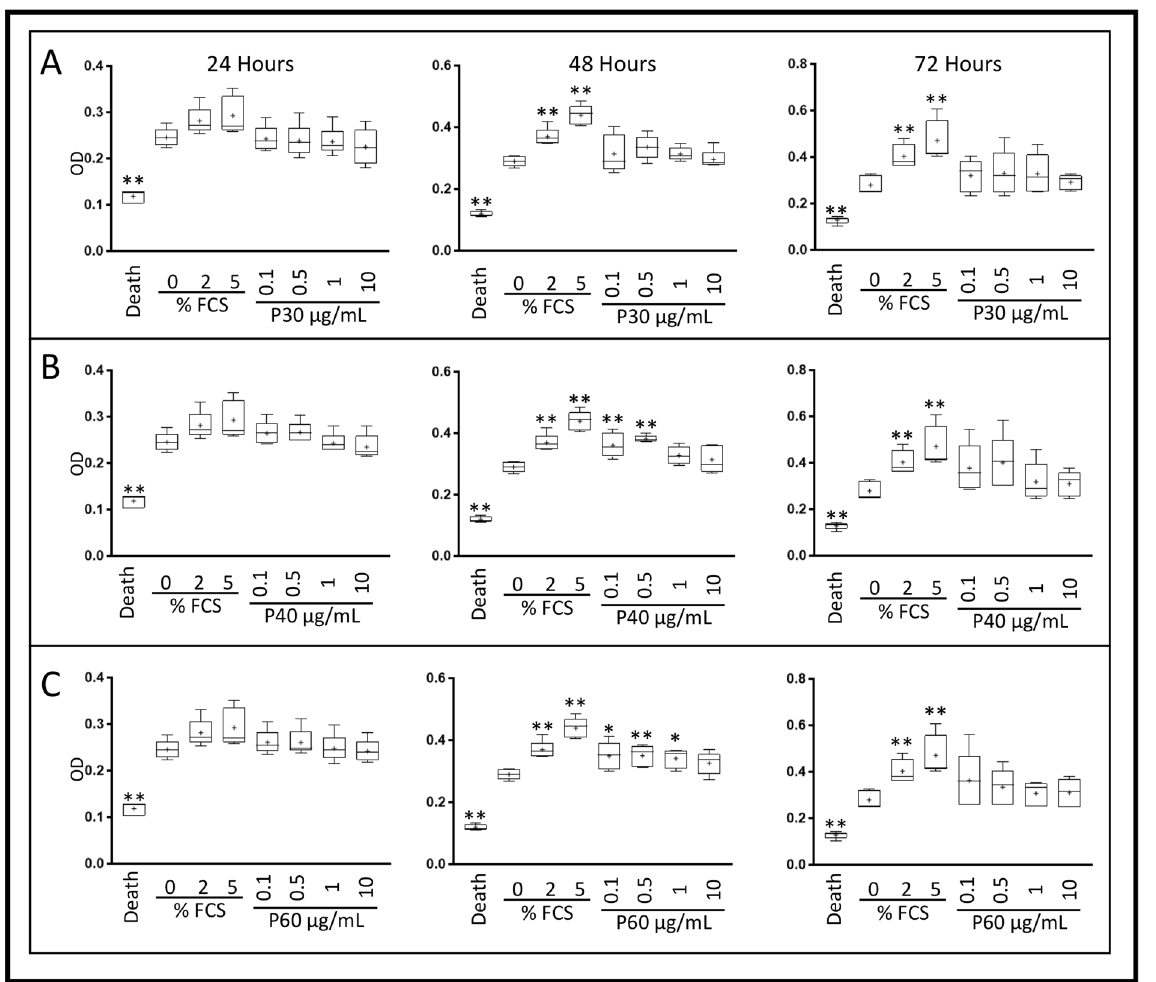
Figure 2. Effect of low concentrations of Promerim ® 30, 40, and 60 on the mitochondrial activity of equine articular chondrocytes cultured in the absence of serum. Equine articular chondrocytes were amplified and seeded at P3. At 80% of confluency, the cells were treated with Promerim ® 30 ( A ), 40 ( B ), 60 ( C ) at several concentrations (0.1, 0.5, 1, and 10 µg/mL) in the absence of FCS and then cultured for 24, 48 and 72 h in hypoxia. Controls with 0%, 2% and 5% of fetal calf serum (FCS), and a death control (triton-induced death) were included. The levels of formazan were measured (OD) in the media at the end of the incubation period (XTT kit, Roche). Data are represented as box plots ( n = 5). Statistical analyses were performed using the Mann–Whitney test (* p < 0.05; ** p < 0.01) and the 0% FCS condition was used as a reference. P30, P40, and P60: Promerim ® 30, Promerim ® 40 and Promerim ® 60.